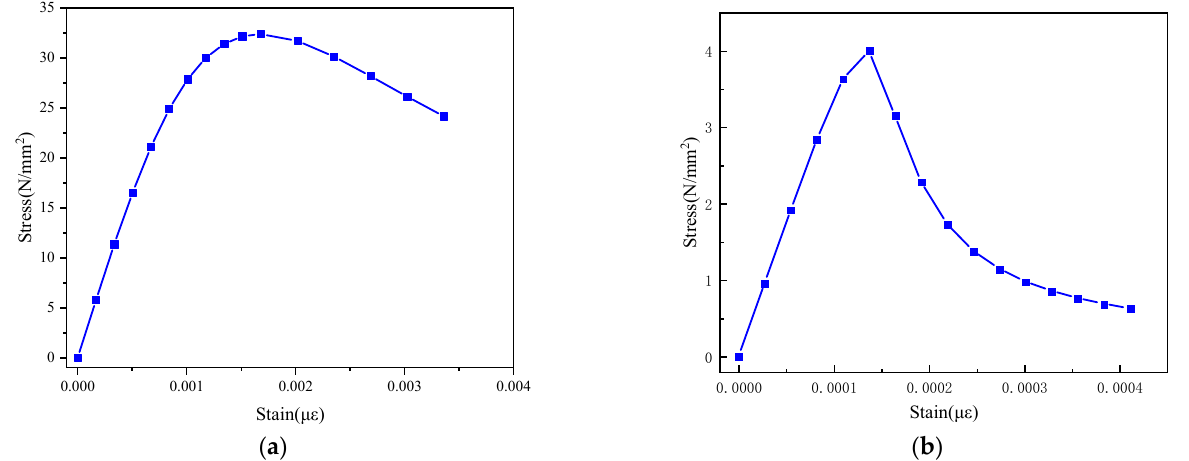
Figure 11. Stress-strain curve of concrete. ( a ) The compressive stress-strain curve. ( b ) The tensile stress-strain curve.